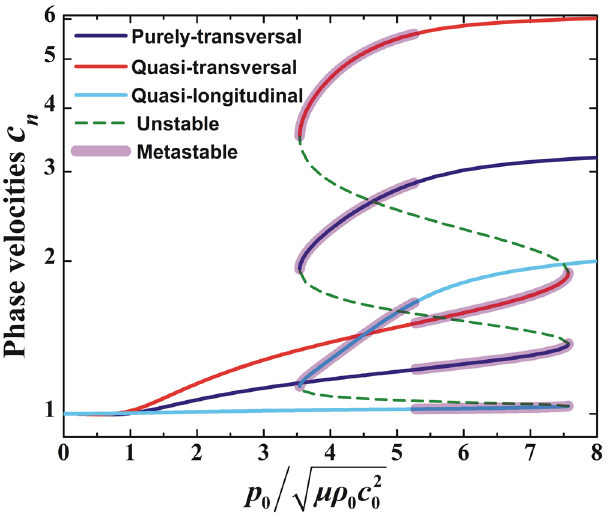
Figure 6. Normalized phase velocities of purely-transversal, quasi-transversal and quasi-longitudinal waves plotted as functions of acoustic input in the direction = n [0 3/2 1/2] . Dashed lines represent unstable region, and metastable region is identified by applying the Maxwell